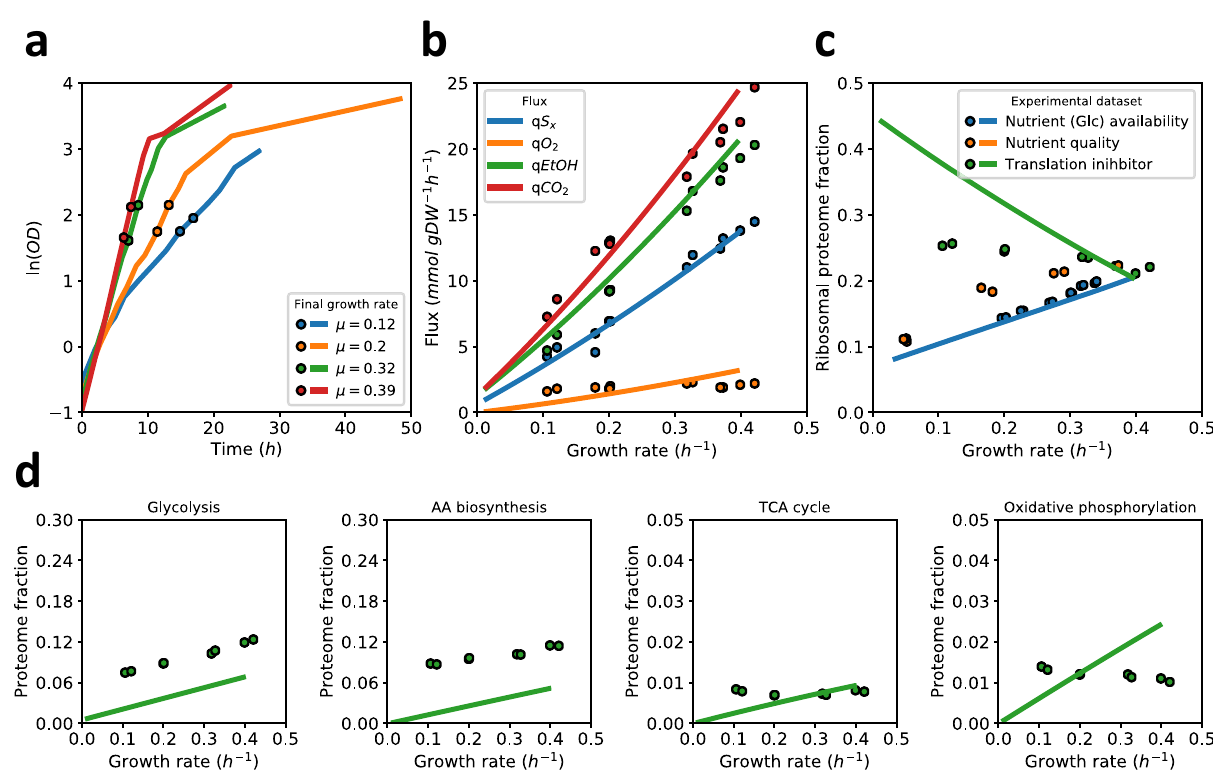
Fig. 5 The effect of translation inhibition by cyclohexamide on growth rate, fl uxes and proteome fractions in controlled aerobic batch fermentations on glucose. a Dependency of culture optical density (OD) on the time post-inoculation to the medium supplemented with cycloheximide. Lines are values of consecutive OD measurements, points represent the times when cultures were sampled. b – d Comparison of pcYeast predictions and experimental data: lines are model predictions; symbols are experimental data points. b Main catabolic fl uxes as a function of the growth rate. c Ribosomal proteome fractions. Data from Fig. 1c are included for comparison. d Proteome fractions measured for key metabolic pathways, and the minimal proteome fractions predicted by pcYeast. Individual proteins in panel d were mapped to metabolic pathways using a manually-curated pathway annotation fi le (Supplementary Data 5). Source data are provided as a Source Data fi